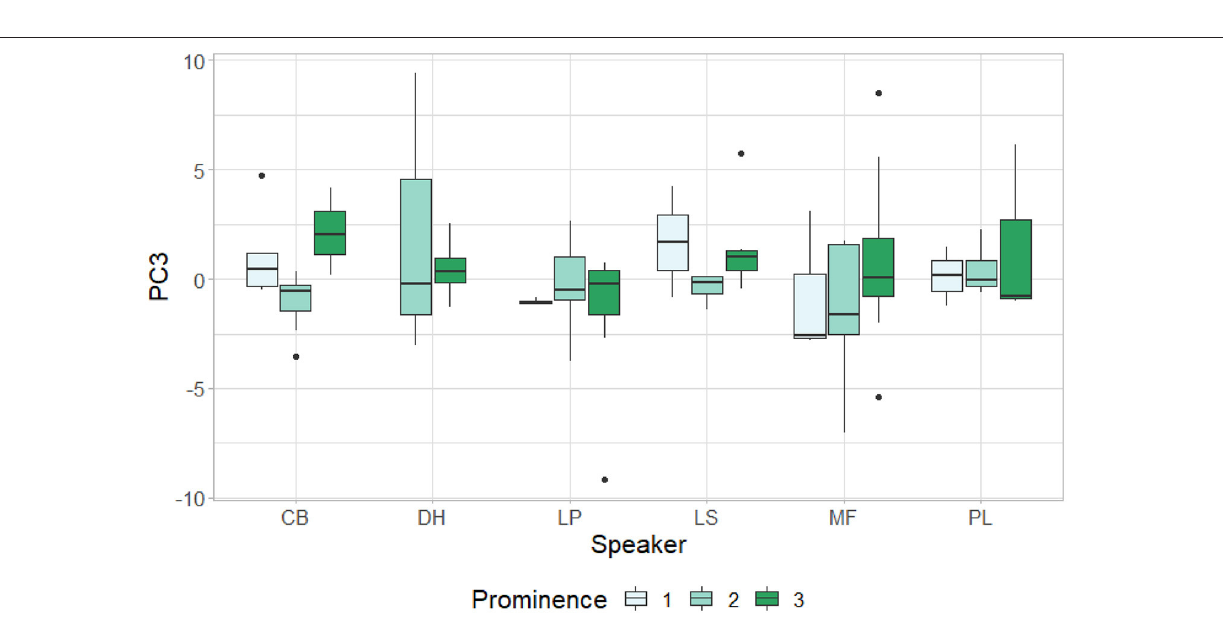
FIGURE 9 | Values of the third PC for each speaker across prominence